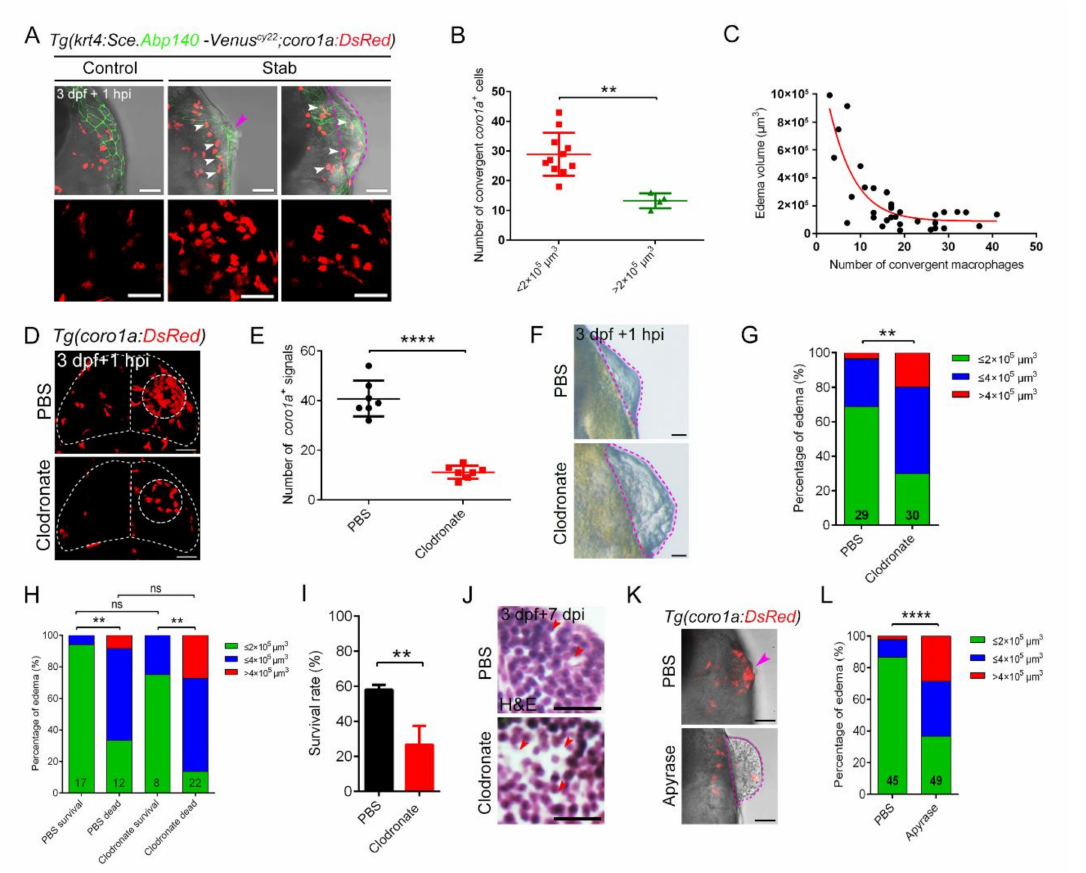
Figure 4. The dense structure of macrophages played an important role in maintaining brain in- tegrity and survival of injured zebrafish larvae. ( A ) Edematous phenotypes appeared in injured Tg(coro1a:DsRed;krt4:Sce.Abp140-Venus) cy22 with a few macrophage aggregations. The white arrow- heads in upper images indicate the distribution of macrophages after injury. Purple arrowhead indicates a mild edematous phenotype. The purple dotted line indicates a severe edematous phe- notype. Scale bar, 50 µ m. ( B ) Statistical analysis of aggregated coro1a + cells number in ( A ). Control, 28.91 ± 2.19 n = 11; Stab, 13.25 ± 1.25 n = 4. ( C ) The correlation between edema-like symptoms and the number of aggregated macrophages. ( D ) The distribution of macrophages after injury with clodronate liposomes or PBS injection. Scale bar, 50 µ m. ( E ) Statistical analysis of aggregated coro1a + cells in ( D ). PBS, 40.86 ± 2.72 n = 7; Clodronate, 11.14 ± 0.99 n = 7. ( F ) Observation of edema-like symptoms after injury. Scale bar, 50 µ m. ( G ) Statistics of edematous symptoms in ( F ). ( H ) Analysis of zebrafish survival and edematous symptoms in Clodronate/PBS treatment group after injury. ( I ) Survival rate of zebrafish at 1 dpi. ( J ) H&E staining of brain tissue at 7 days after injury. Scale bar, 10 µ m. Red arrowheads indicate locations of apparent tissue loss. ( K ) The bright field and fluorescent images of coro1a -DsRed + cells and edema-like symptoms by treatment with Apyrase/PBS. Scale bar, 50 µ m. Purple arrowhead indicates a mild edematous phenotype. The purple dotted line indicates a severe edematous phenotype. ( L ) Statistics of edematous symptoms by treatment with apyrase/PBS. (Data are shown as mean ± SEM. ns , no significance; **, p < 0.01; ****, p <